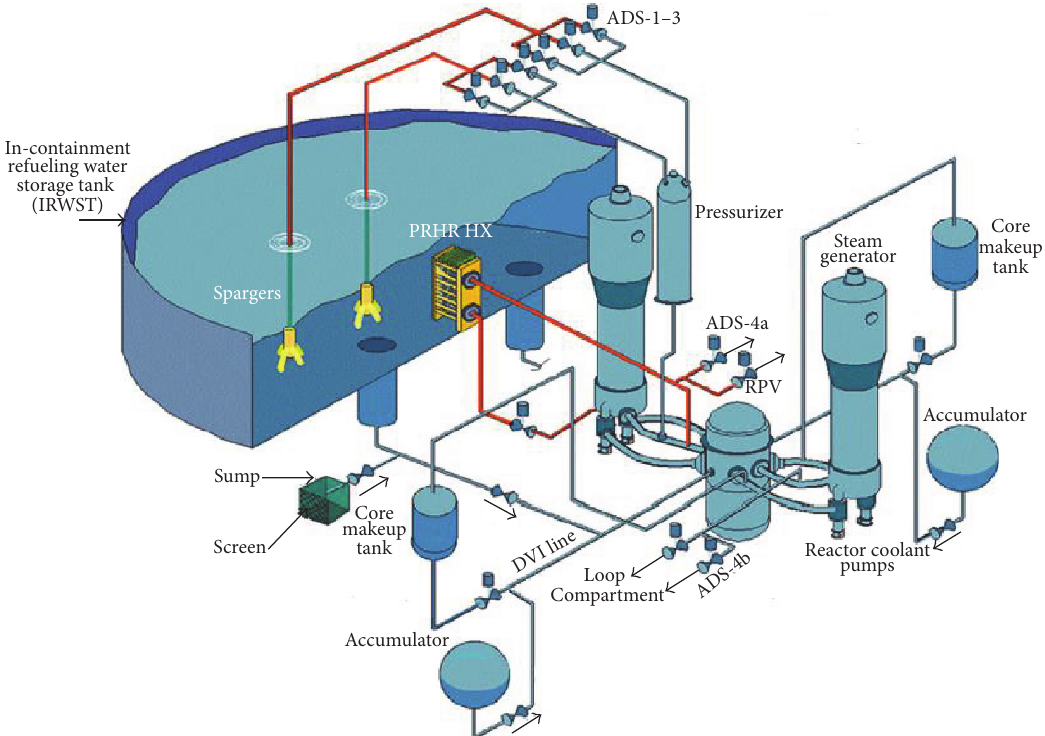
Figure 1: Schematic diagram of AP1000 passive safety